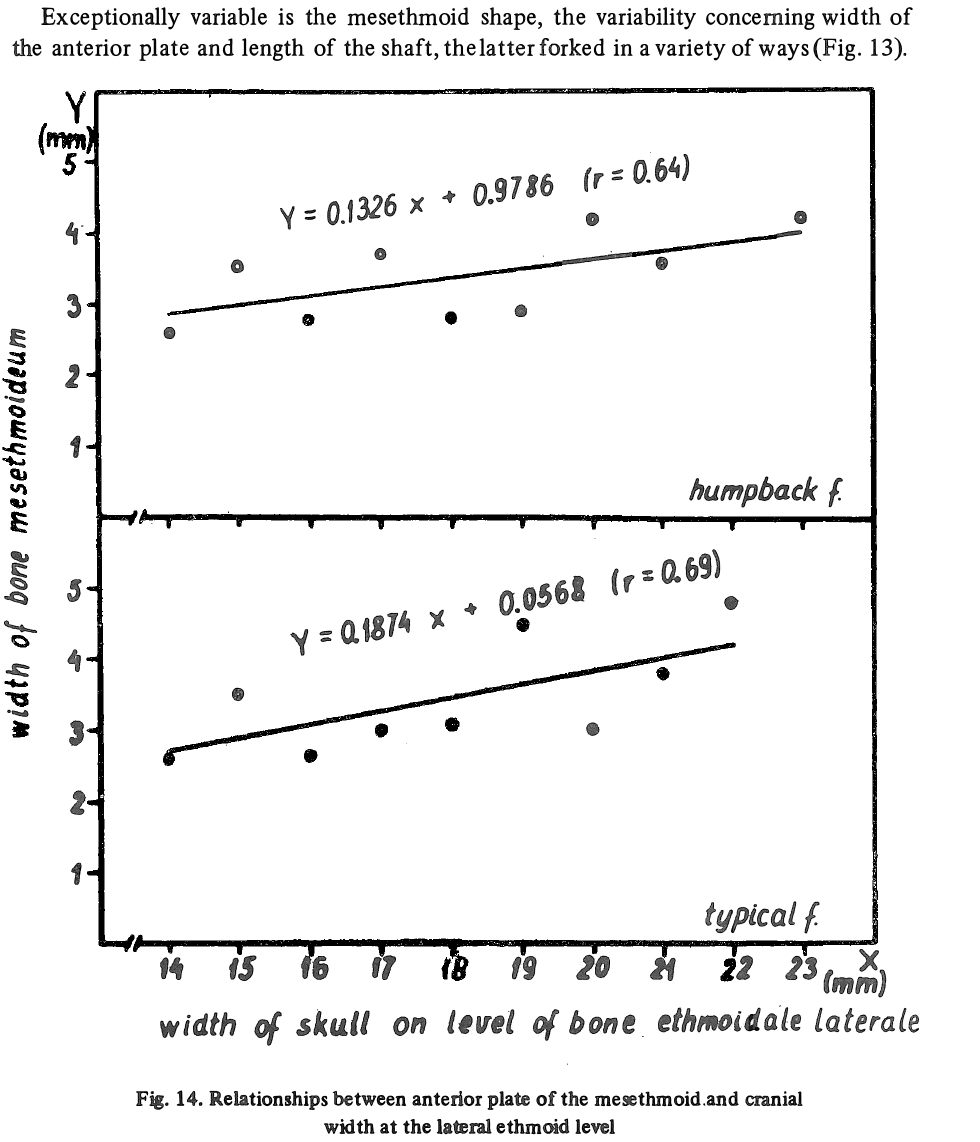
Fig. 14. Relationships between anterior plate of the mesethmoid.and cranial width at the lateral ethmoid